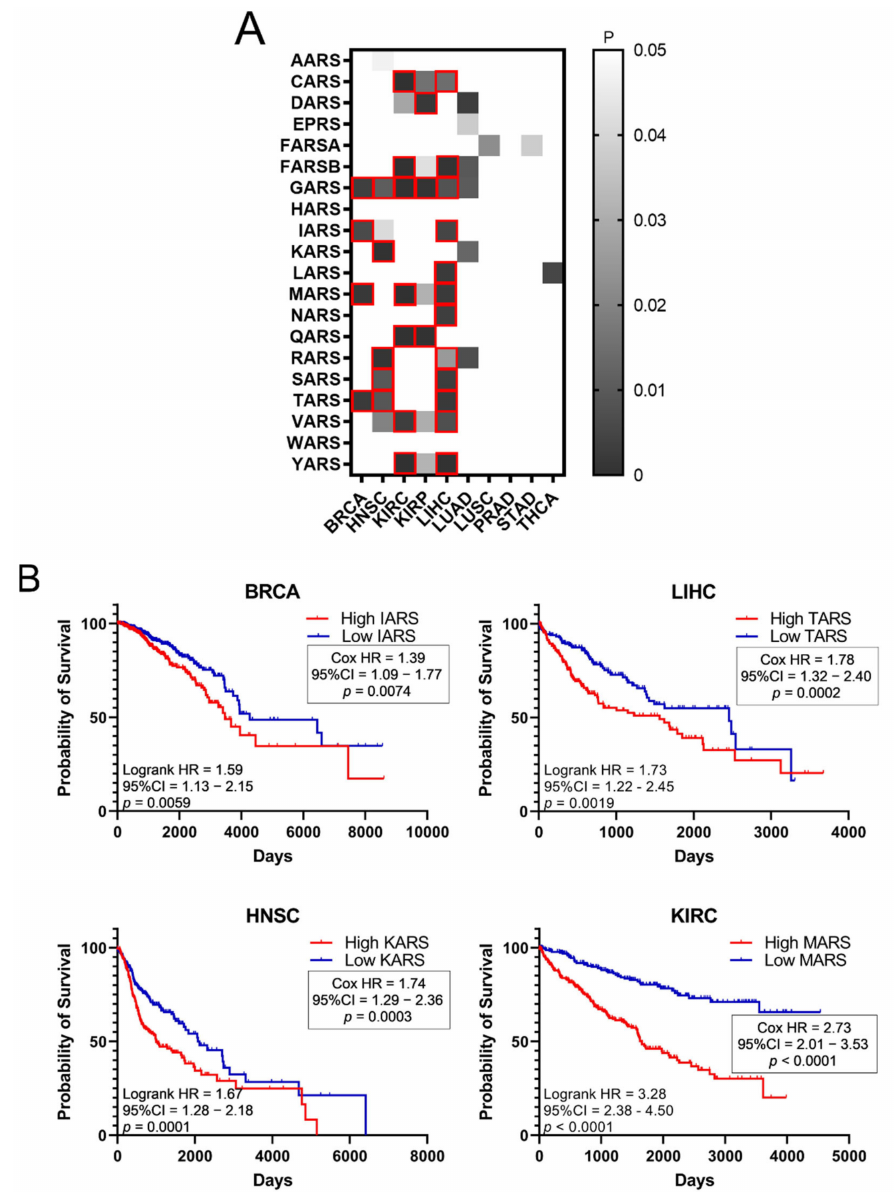
Figure 3. Survival of patients with upregulated or downregulated ARS expression. ( A ) Patient survival p -values in tumours with deregulated ARS expression. The grey squares represent p < 0.05. The red outlines represent q < 0.05, higher ARS expression and worse patient survival. ( B ) Indicative Kaplan–Meier survival plots of patients with tumours presenting upregulated ARS